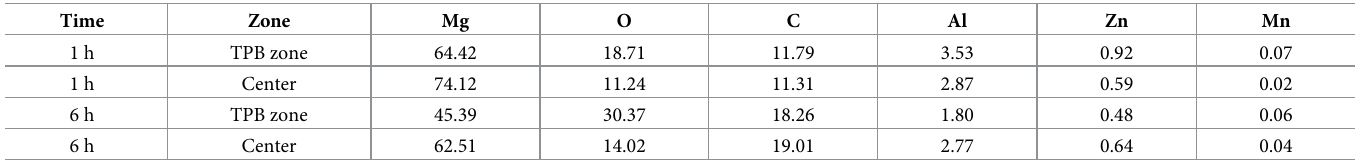
Table 1. EDS data of the AZ91D alloy surface for the major elements (atomic %). Time